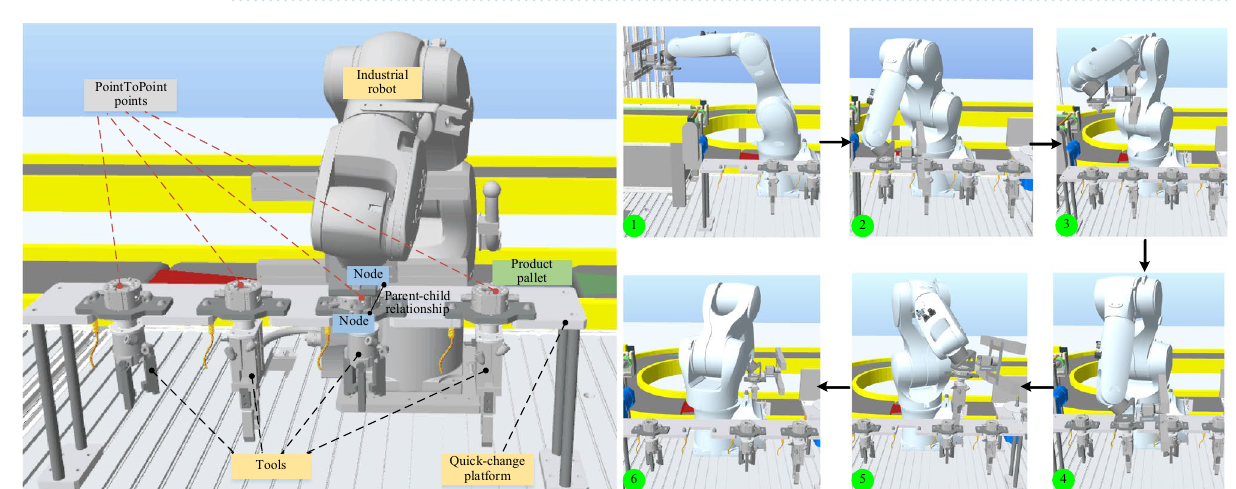
Figure 5. Dynamic behavior mapping from PE to